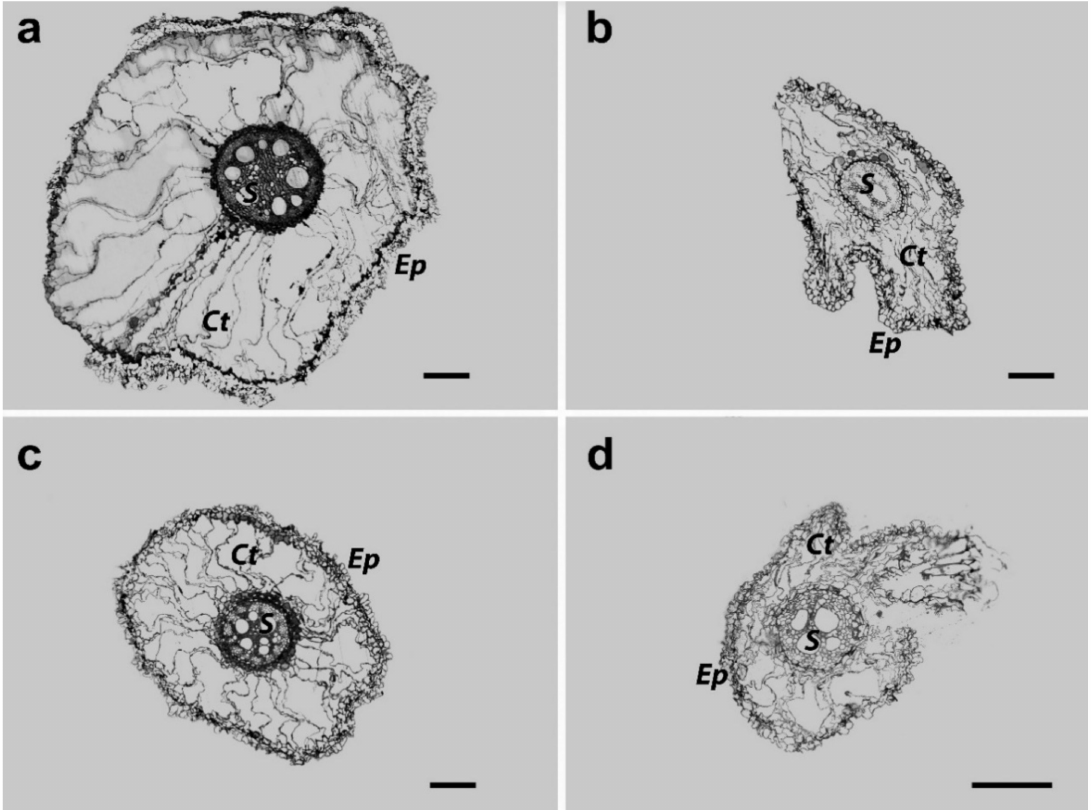
Figure 4. Cross-section of the roots; T. australis : ( a ) background plot (5K), ( b ) polluted plot (8K); T. laxmannii : ( c ) background plot (T1), ( d ) polluted plot (T4). Ep—epidermal cells; Ct—cortex; S—central cylinder (stele). The scale bar is 100 µ